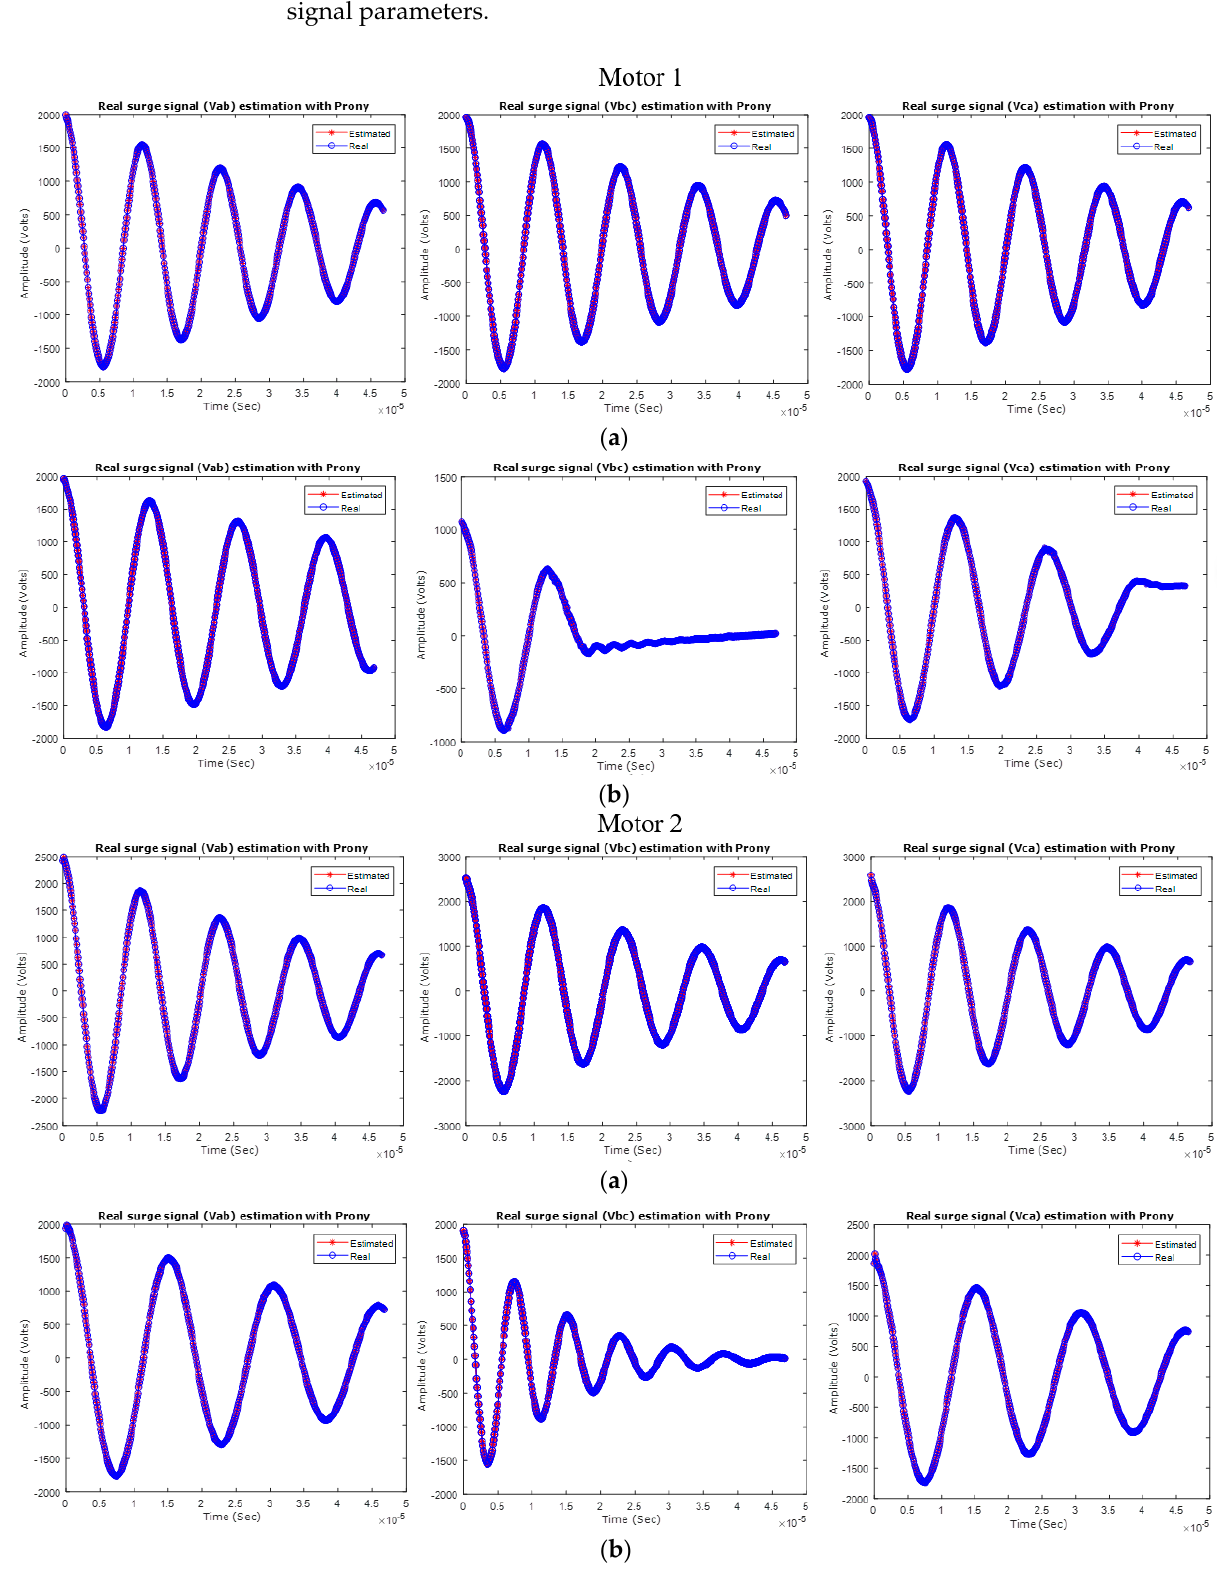
Figure 8. Real surge waveforms curve fitting estimation ( a ) No fault ( b ) Fault . Motor 1 and Motor 2